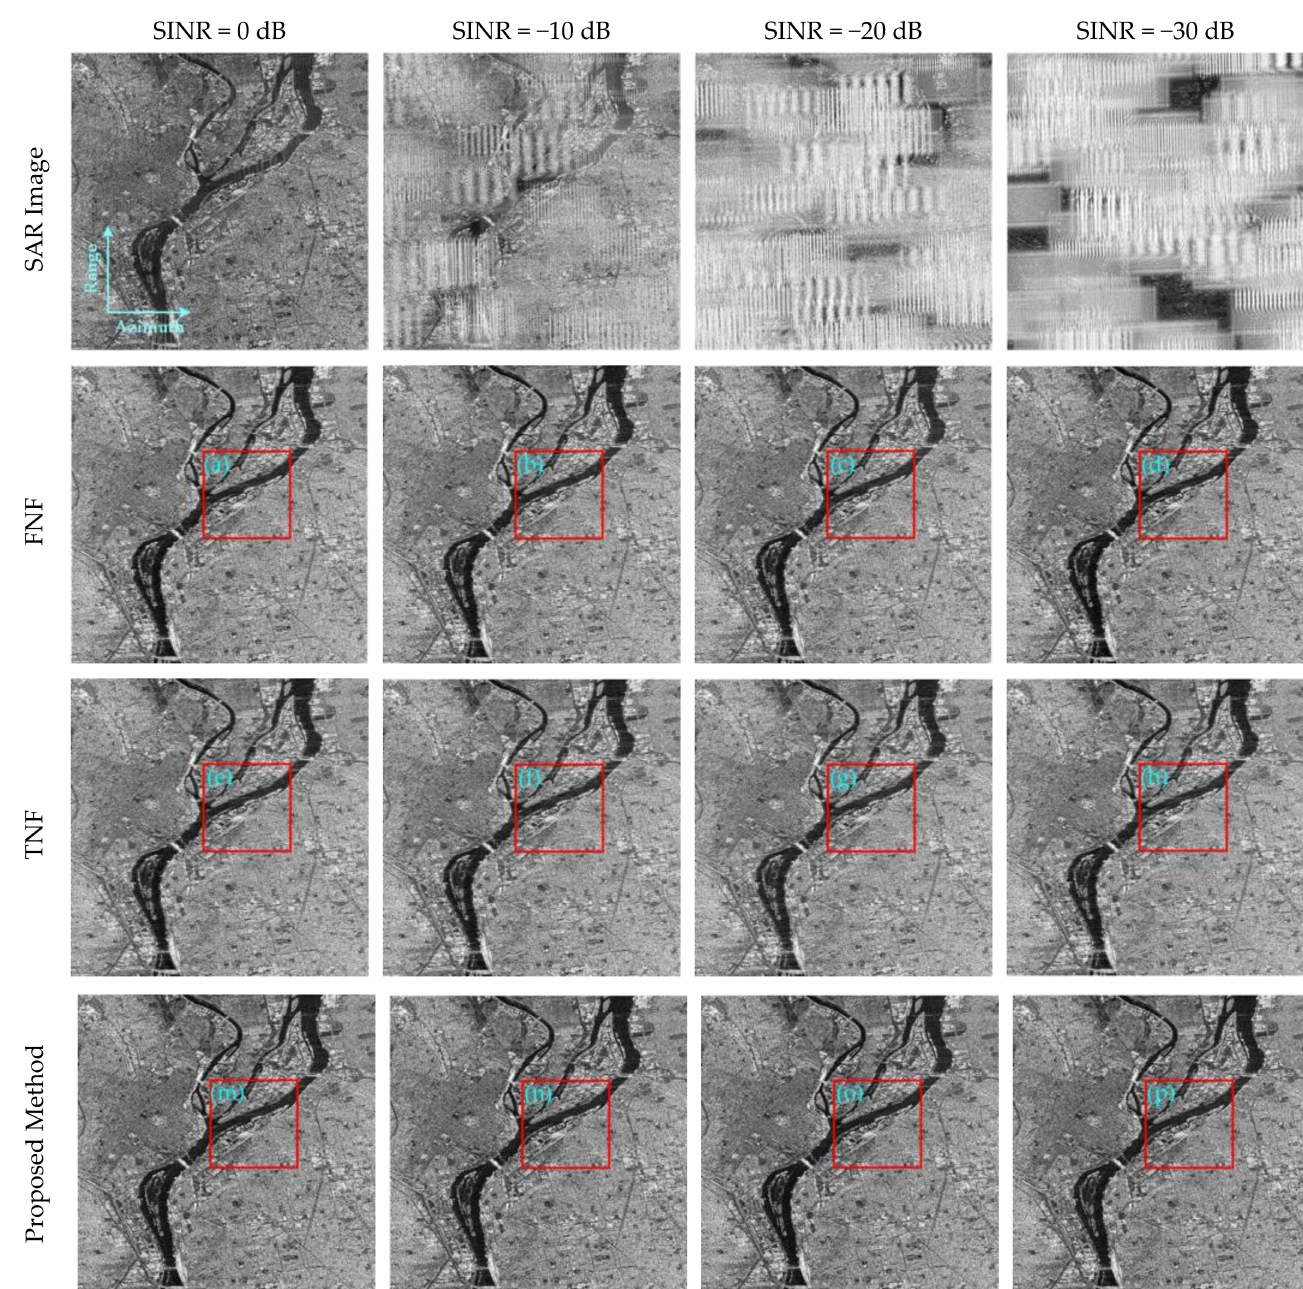
Figure 6. RFI mitigation performance for the FNF, TNF, and proposed method under different SINR